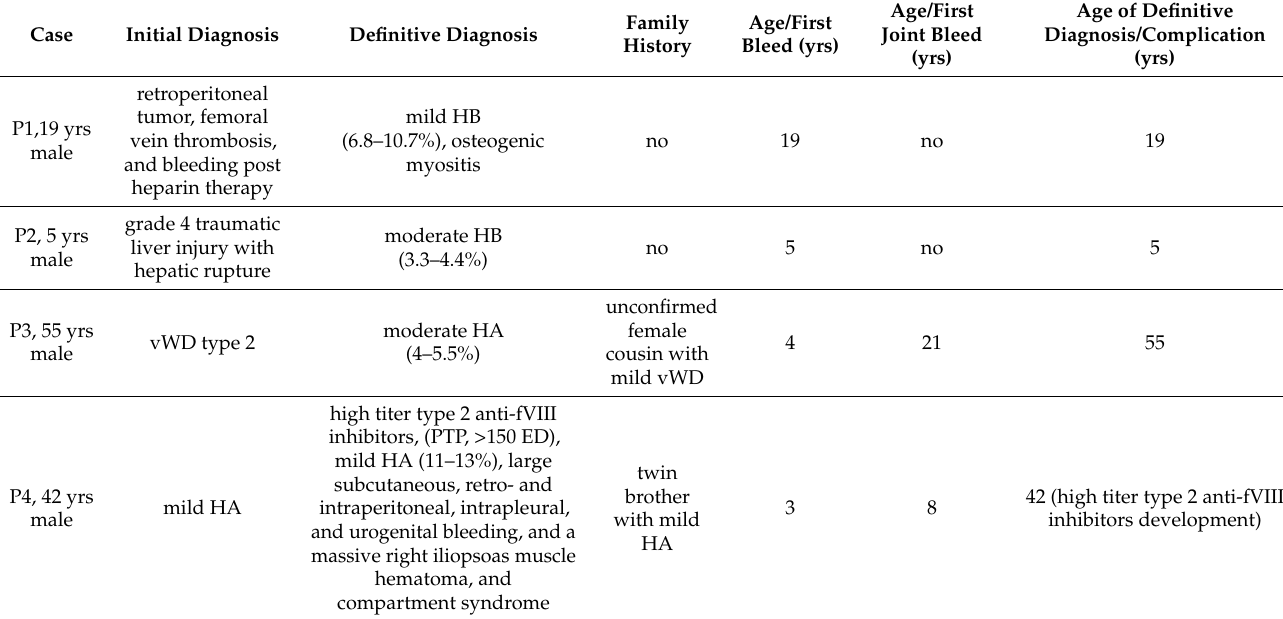
Table 1. Characteristics of the case